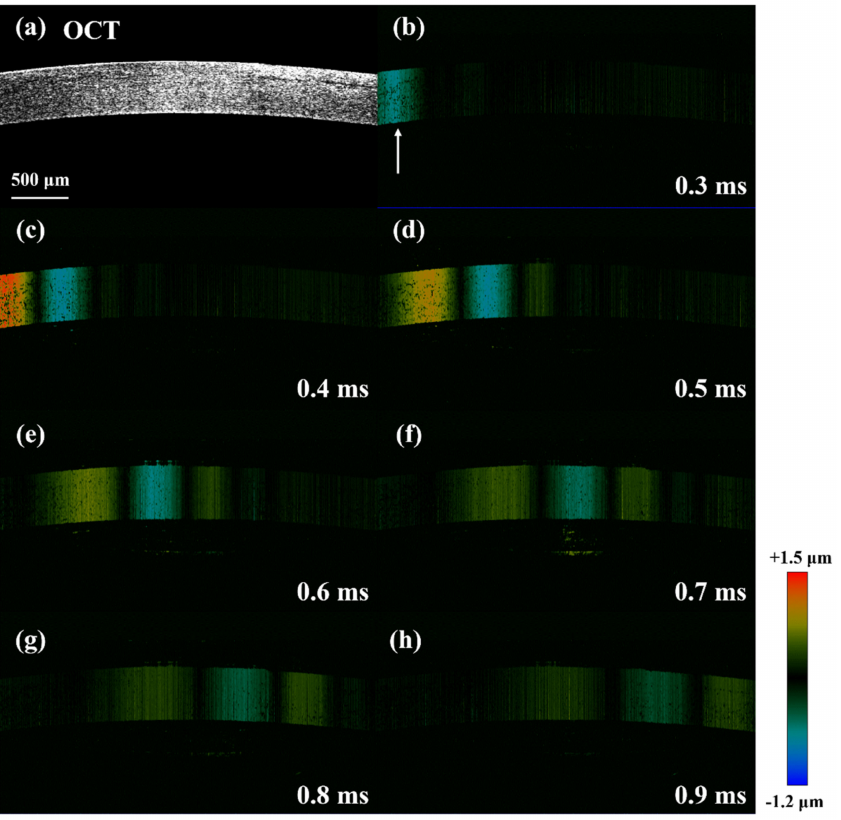
Figure 5. Doppler OCT (D-OCT) B-scans of the cornea. ( a ) The B-scan OCT image of the cornea. ( b – h ) The B-scan D-OCT images of the